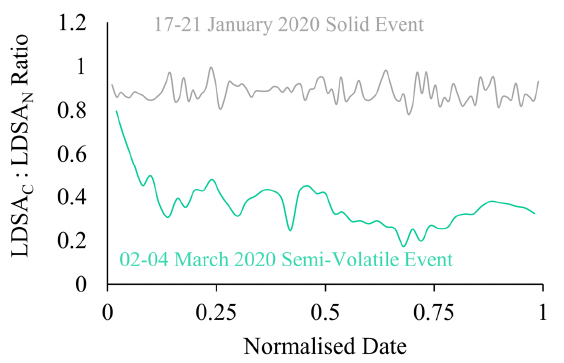
Figure 7. Ratio of LDSA C to LDSA N for semi-volatile (green) and solid (grey) sampling events versus a normalised date.